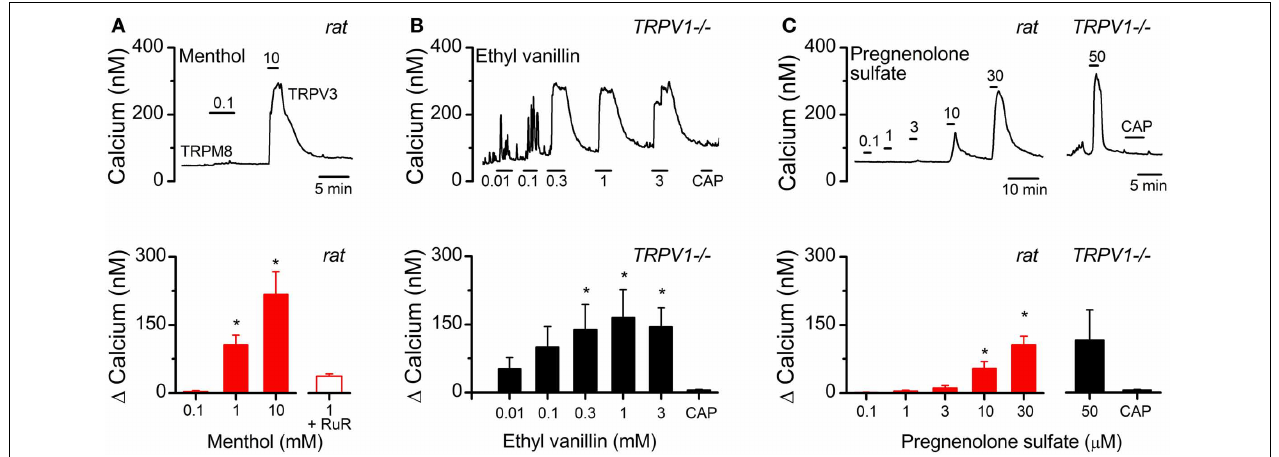
vagal afferents taken from TRPV1 − / − mice. CAP exposure failed to elicit a response as predicted. (B , lower panel ) Average concentration response relationship for ethyl vanillin induced increases in cytosolic calcium ( N = 5, P = 0 . 002, ANOVA). (C , upper panel ) Left: Calcium trace showing the TRPM3 agonist pregnenolone sulfate concentration-dependently activated a subpopulation of CAP-sensitive vagal afferent neurons. Right: This response was maintained in afferents taken from TRPV1 − / − mice. (C , lower panel ) Average change in intracellular calcium across concentrations from pregnenolone sulfate responsive neurons from rat ( N = 8, P < 0 . 001, ANOVA) and TRPV1 − / − mice ( N = 3, P < 0 . 01, paired T -test). Statistical significance is indicated by an asterisk ( ∗